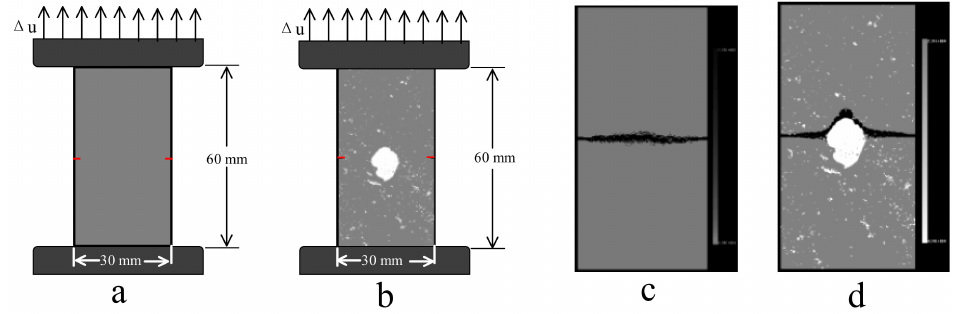
Figure 9. ( a ) The uniaxial tensile test on sandstone specimen in Case III; ( b ) the uniaxial tensile test on glutenite specimen in Case IV; ( c , d ) tests results of Case III, IV, respectively. Table 2. Physico-mechanical parameters of sandstone and gravel. Physico-Mechanical Parameters